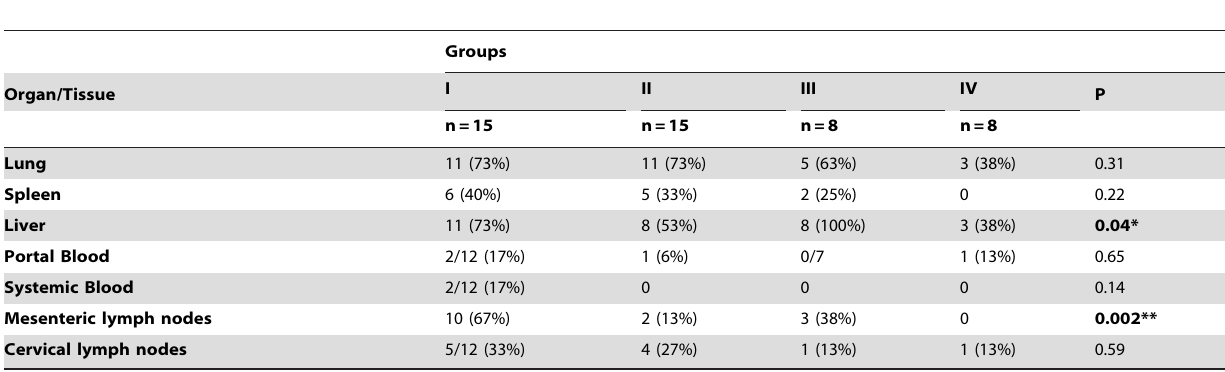
Table 4. Number and proportion of rats with positive microbiological growth for strains of vancomycin-resistant Enterococcus in organs or tissues.